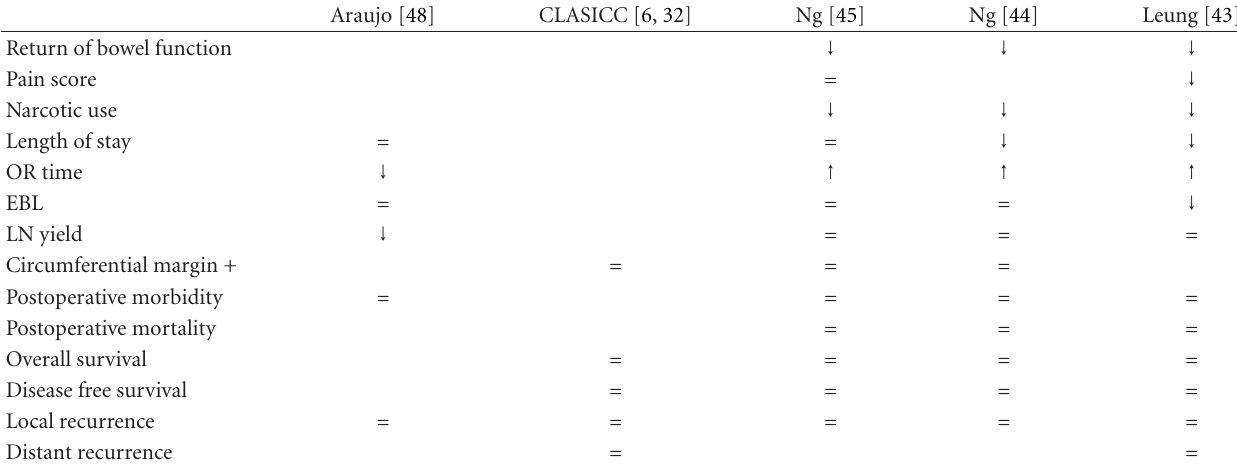
Table 2: Short-term and long-term outcomes of randomized controlled trials for laparoscopic rectal surgery compared to open rectal surgery for rectal